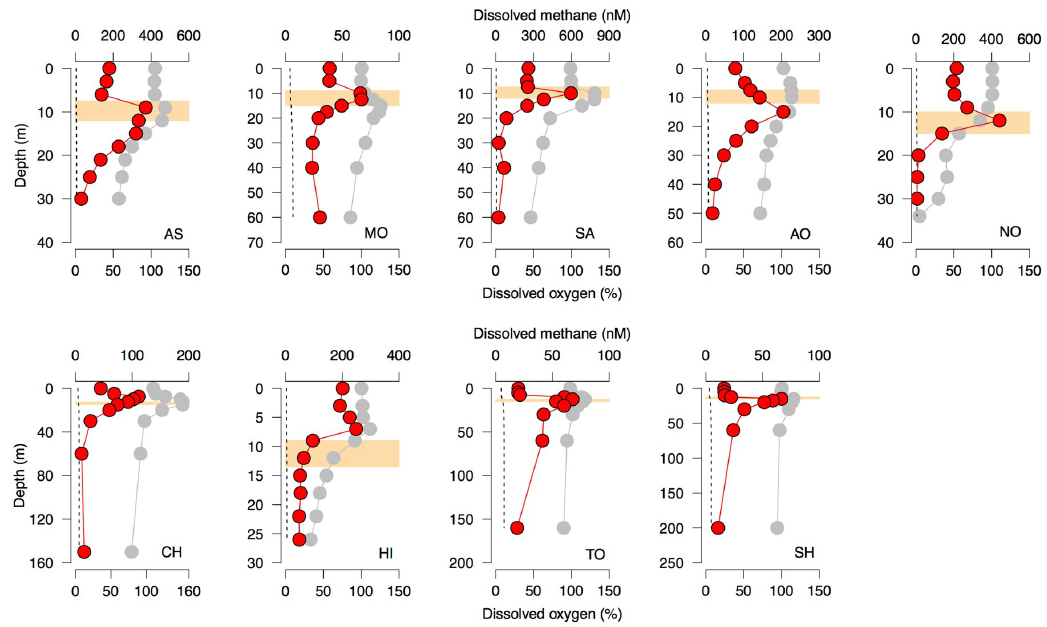
Figure 1. Vertical profiles of dissolved CH 4 concentrations in the nine study lakes of Japan during the July to September in 2016–2017 period. AS: Lake Ashinoko, MO: Lake Motosu, SA: Lake Saiko, AO: Lake Aoki, NO: Lake Nojiri, CH: Lake Chuzenji, HI: Lake Hibara, TO: Lake Toya, SH: Lake Shikotsu. Red and gray circles refer to the dissolved methane (nM) and oxygen (%) concentrations, respectively. Dotted lines denote the atmospheric equilibrium concentration of dissolved CH 4 in lake water (3.7–7.2 nM). Shaded areas denote the range of the thermocline.